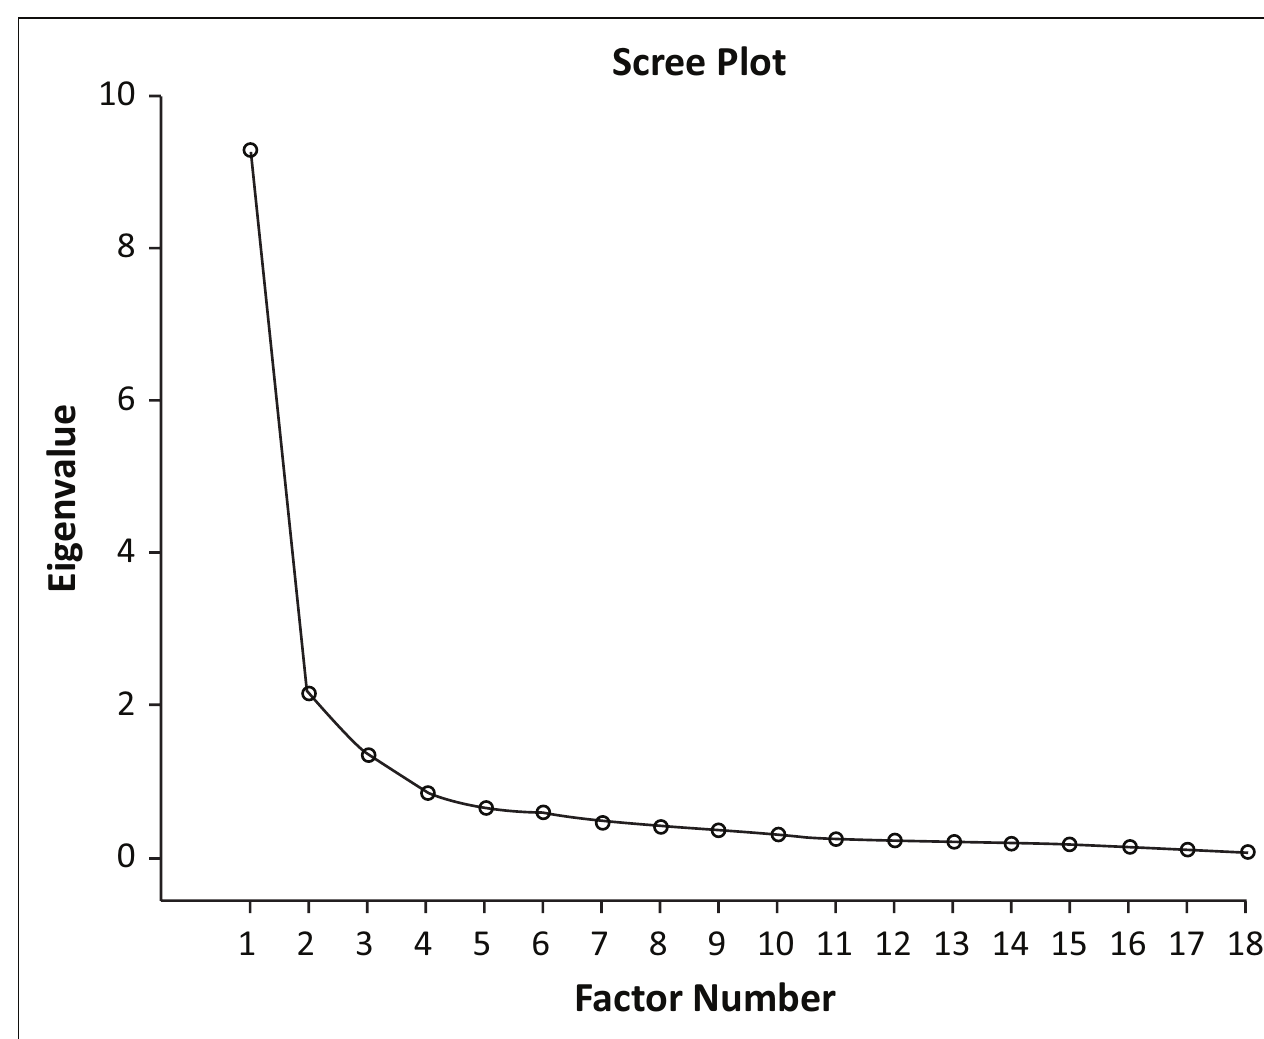
FIGURE 2: Scree plot and extracted eigenvalues suggest a three-factor solution. TABLE 4: Factor’s Univariate descriptive statistics output for the 18 positive emotional experiences items.